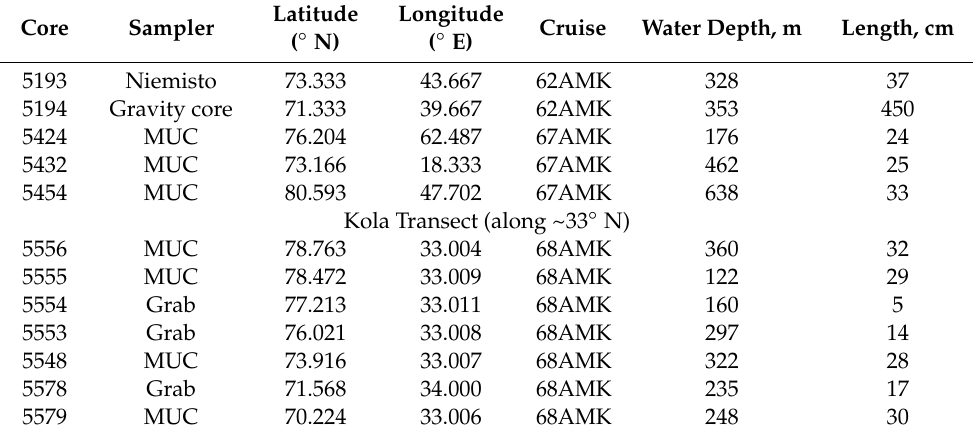
Table 1. The Barents Sea sediment cores studied in this